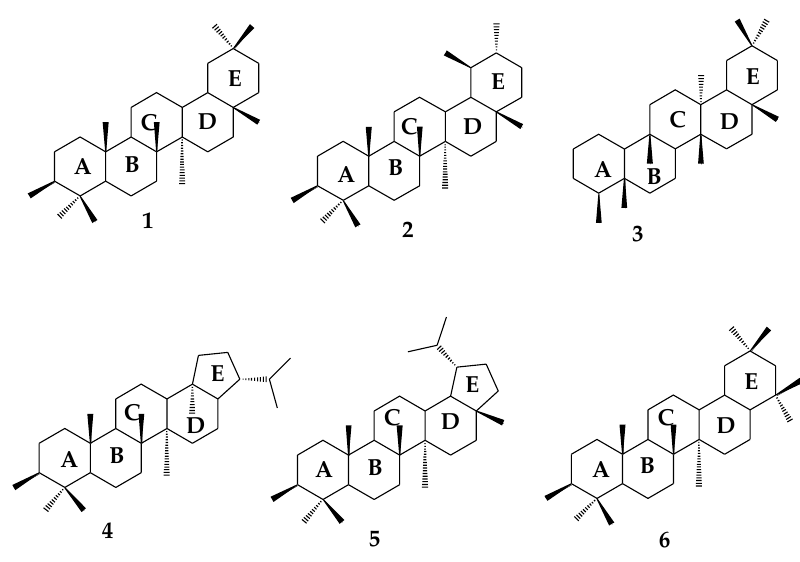
Figure 1. Types of pentacyclic triterpenes structures.